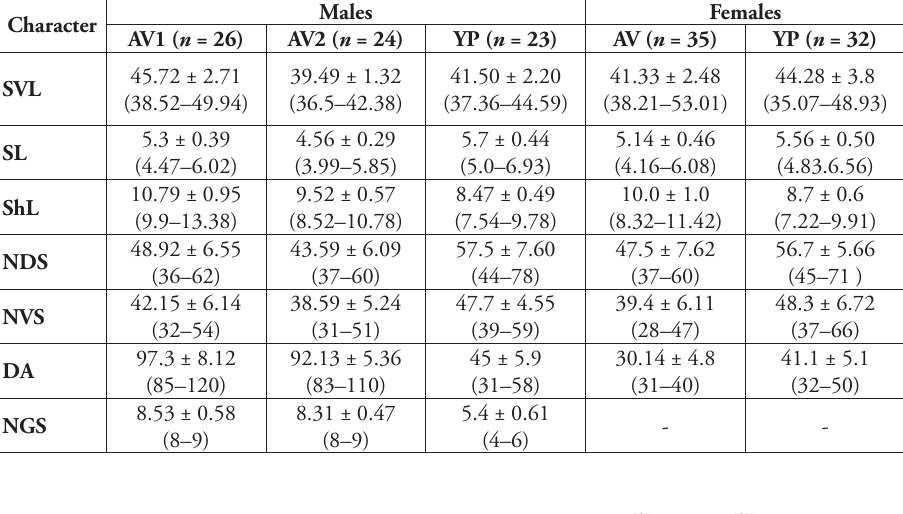
Table 4. Mean ± standard deviation and range for the most important morphological characters accord- ing to the